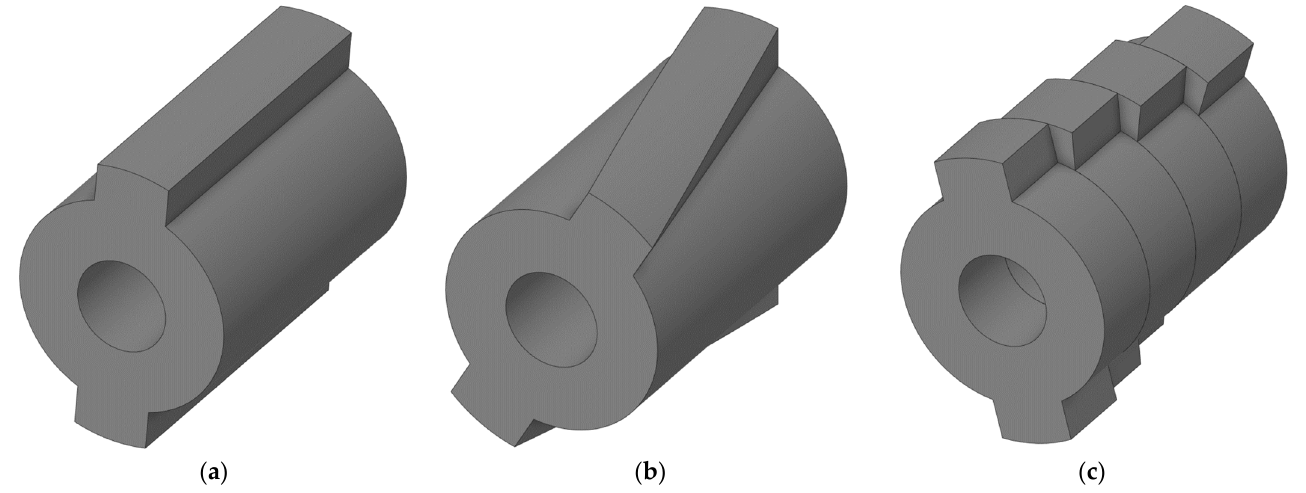
Figure 2. Three-dimensional sketches of different types of skew: ( a ) reference skewless rotor, ( b ) continuous skew, ( c ) discrete skew, also called step skew.